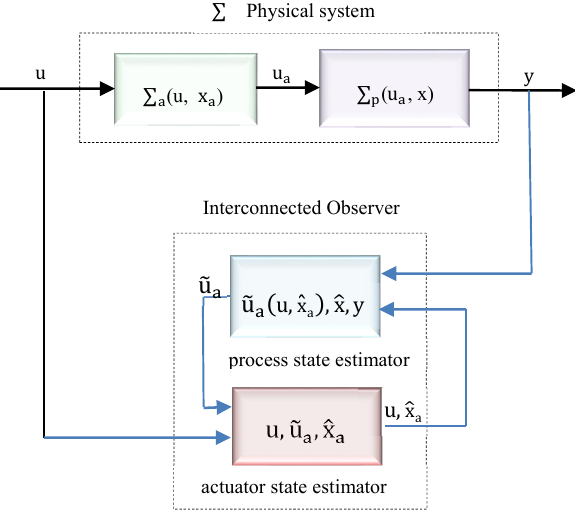
Figure 2. Structure of the proposed interconnected observer.